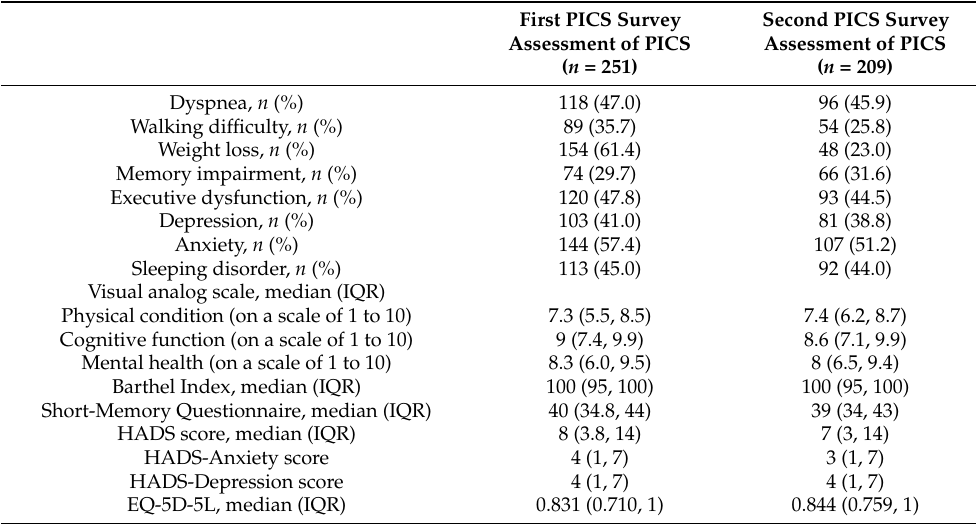
Table 3. PICS outcomes; assessment of PICS in first and second survey.